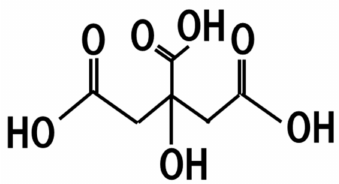
Figure 14. Chemical structure of citric